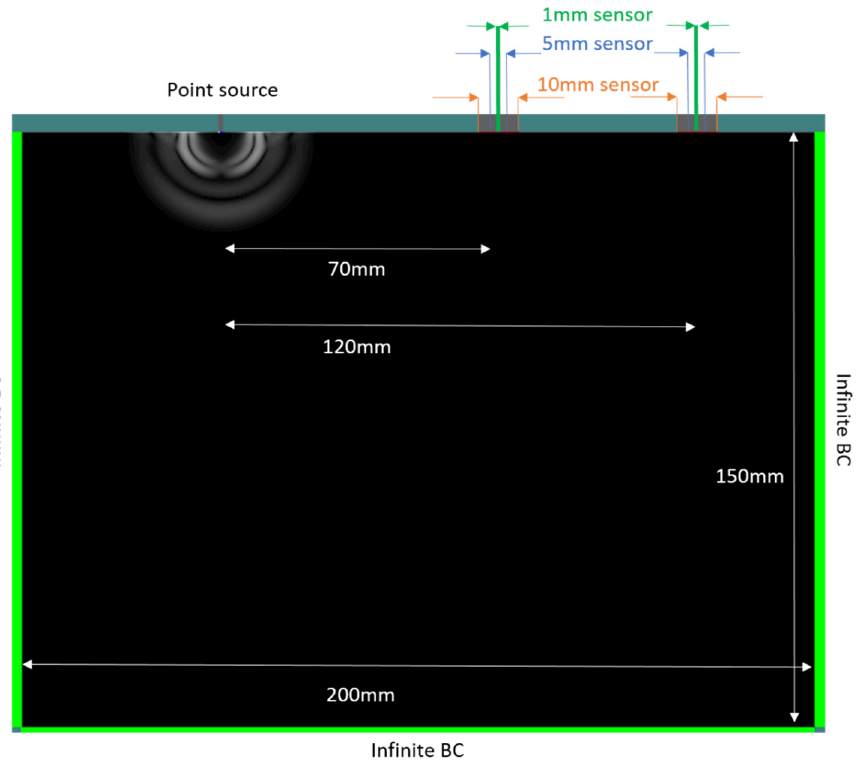
Figure 3. Geometry of the simulation model, showing the position of the source and sensors on the specimen.